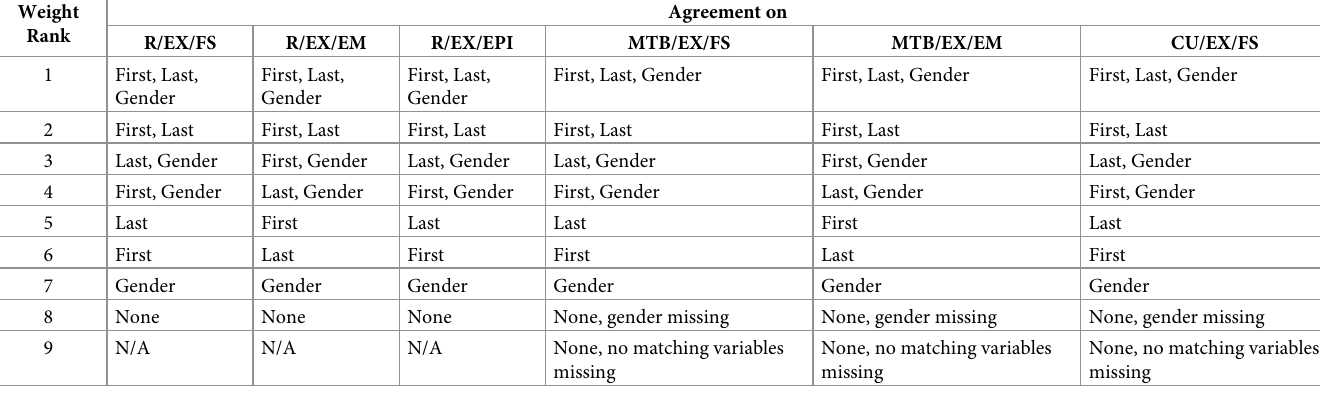
Table 3. Agreement on matching variables for runs with exact string matching, blocking on